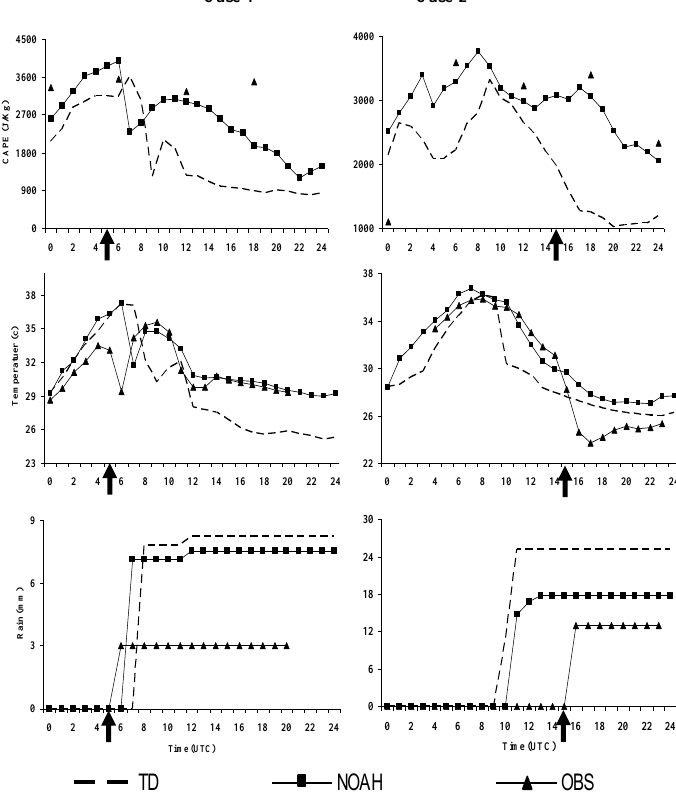
Fig-1:Temporal Evolution of (a) CAPE (J/Kg-1), (b) 2m- temperature (c) and (c) rainfall (mm) over Kolkata for case-1 and case-2 for NOAH and TD scheme. Arrow indicates the time occurrence of thunderstorm.